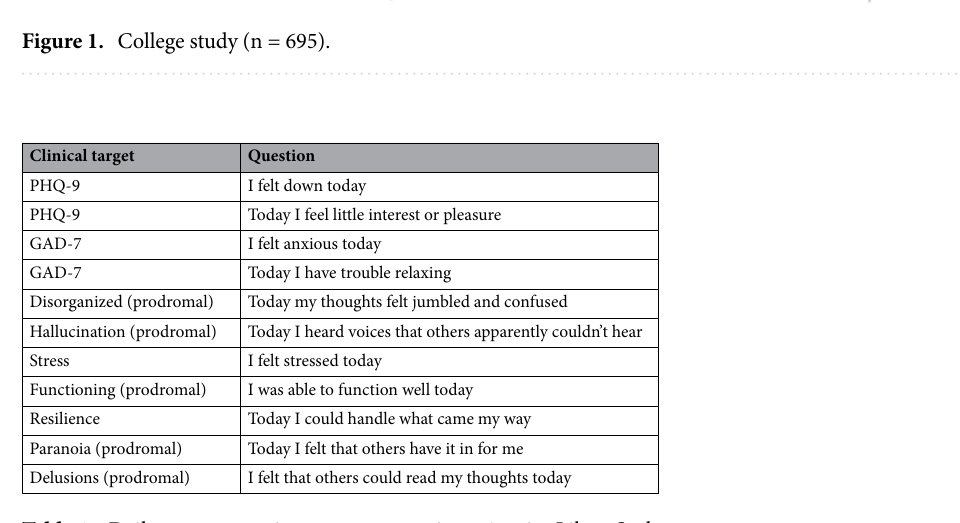
Table 1. Daily survey questions; response options: 4-point Likert